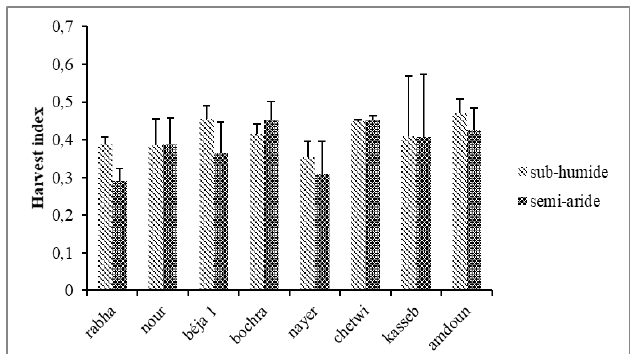
Figure 7: Mean values of harvest index as a function of the interaction’s cultivar × bioclimatic